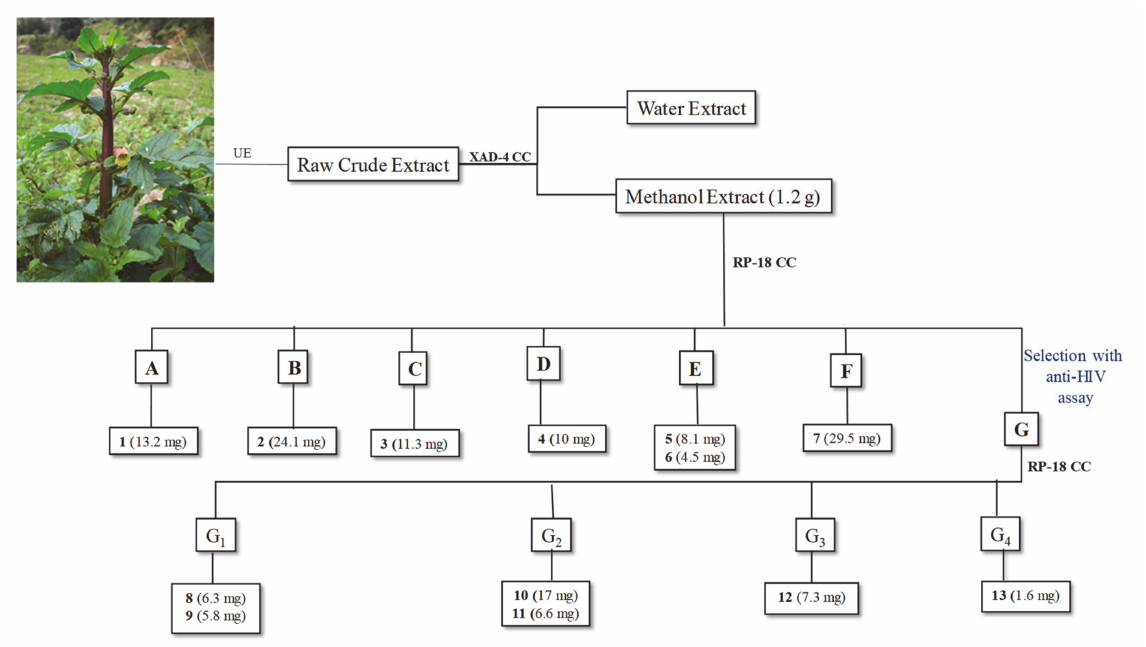
Figure 3. Fractionation scheme of S. trifoliata leaves hydroalcholic crude extract. CC = Column Chromatography; RP = reverse phase; UE = ultrasound extraction. Table 1. NMR data of compound 5 in CD 3